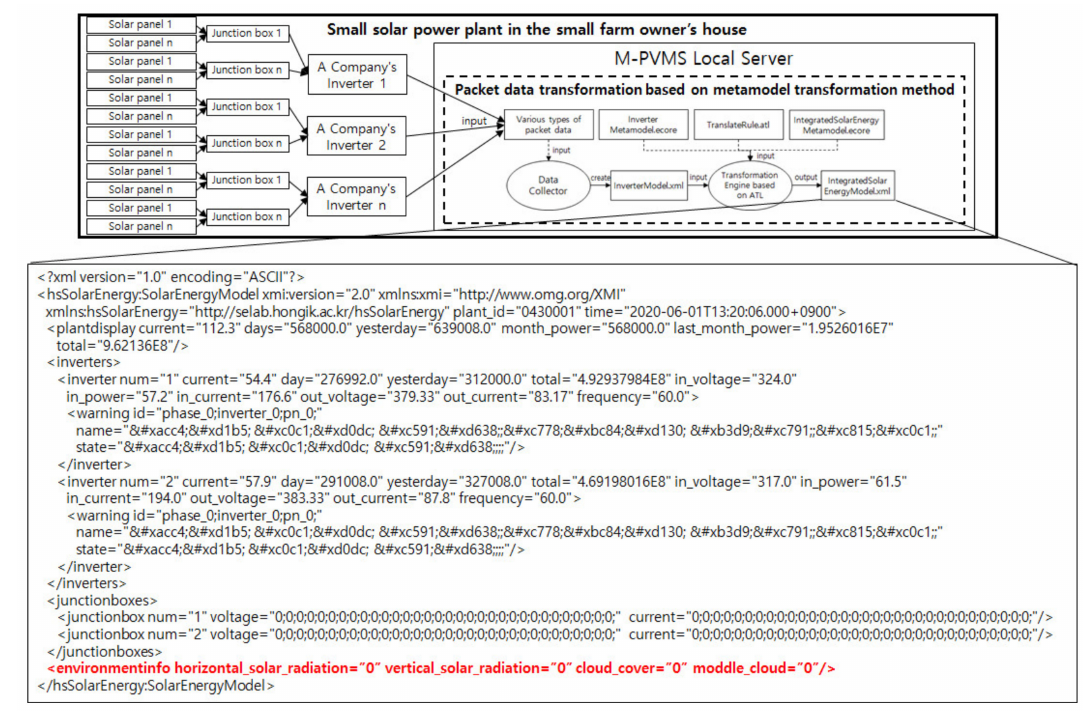
Figure 10. Example code of